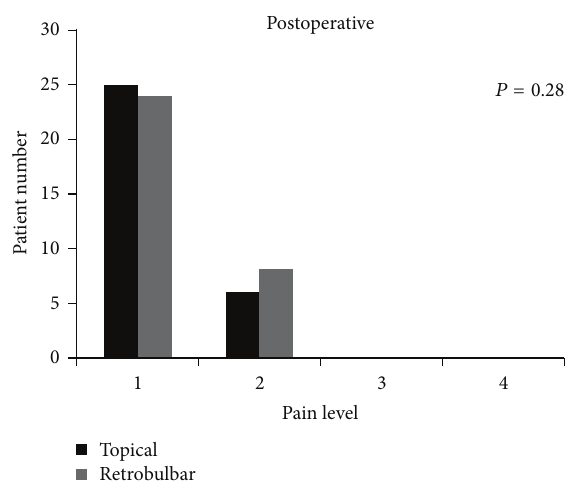
Figure 3: The pain scores recorded for postoperative